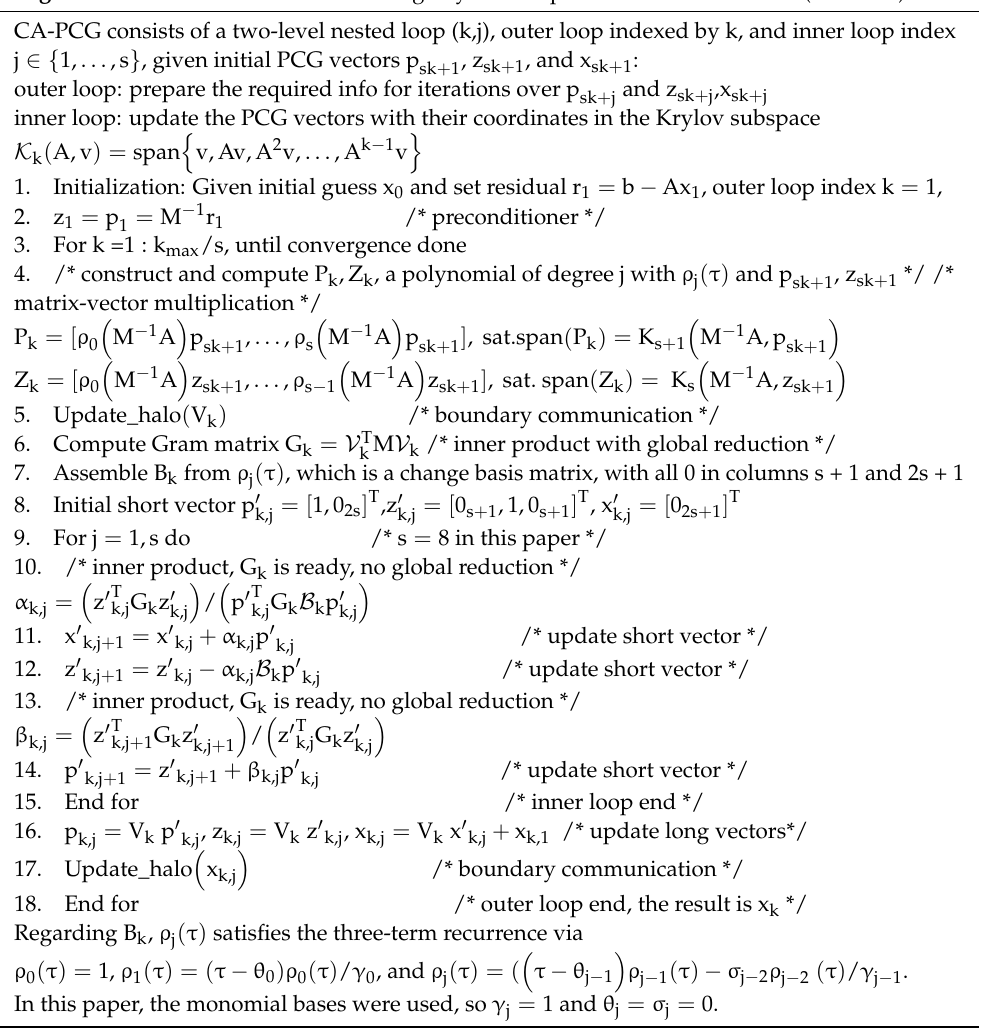
Algorithm A2. Communication-avoiding Krylov subspace method with a PCG